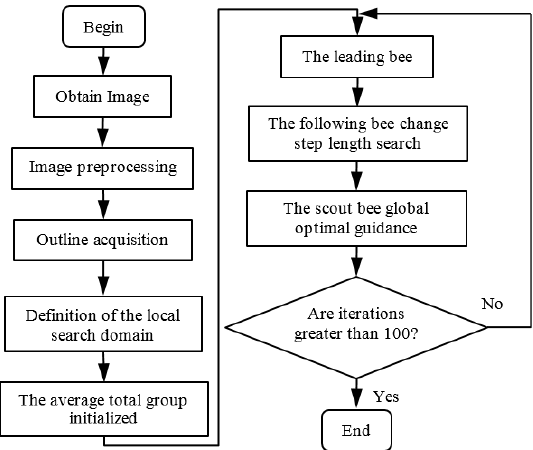
Figure 5. Algorithm flow chart.